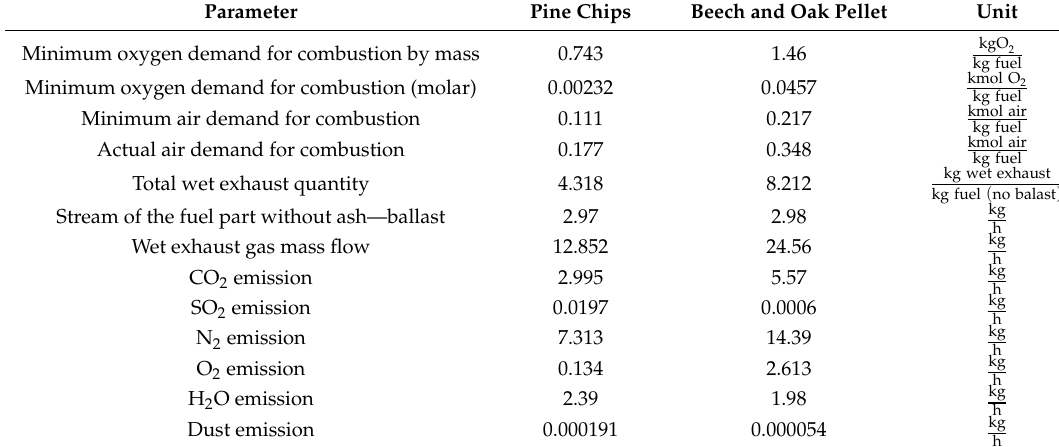
Table 5. Summary of calculation results for the characteristic values of exhaust